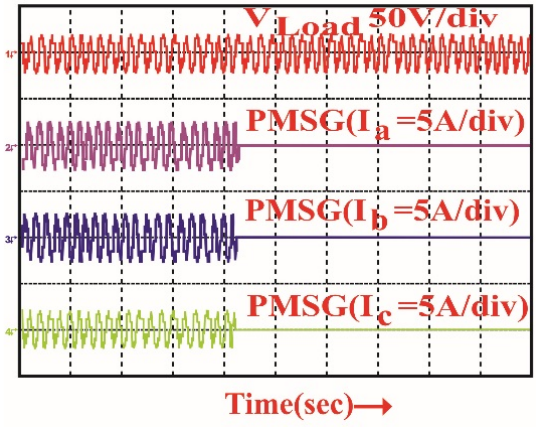
Figure 15. The performance of the wind generator is evaluated under disconnecting operating